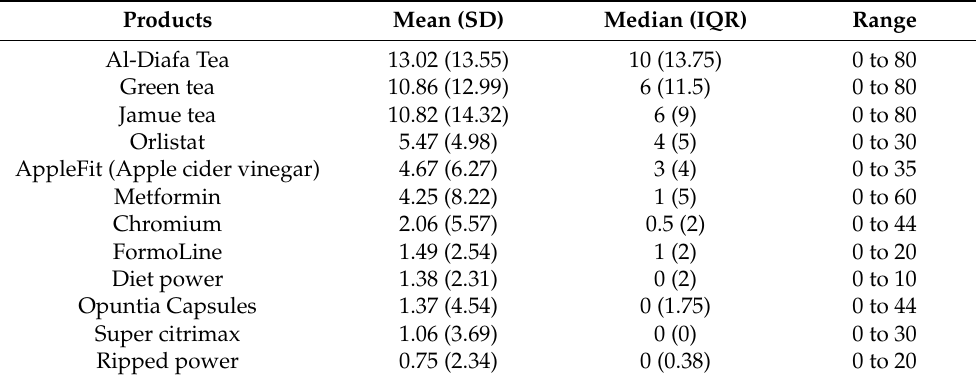
Table 2. Average packs sold for weight loss products per month.